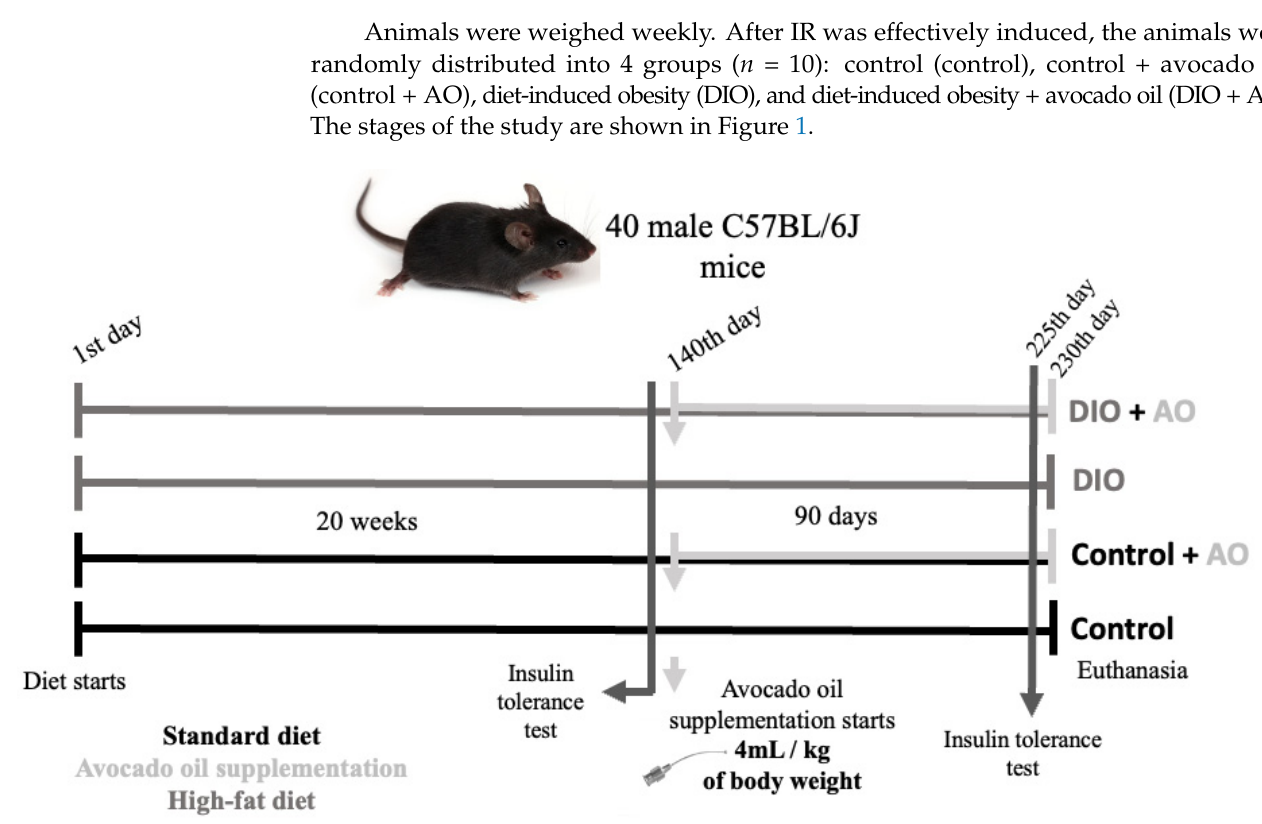
obesity (DIO) groups for 20 weeks and an insulin tolerance test was performed. After both groups received avocado oil (AO) supplementation by gavage for 90 days, another insulin tolerance test was performed, animals were euthanized, and tissue samples were